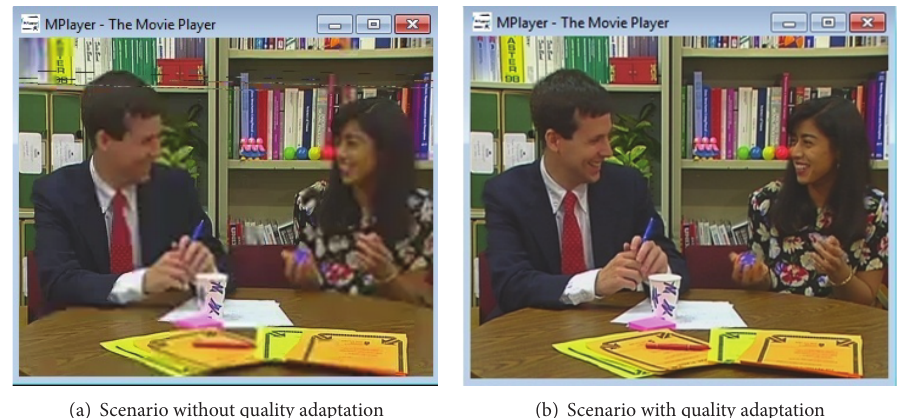
Figure 5: Subjective quality in the scenario without quality adaptation and with quality adaptation by LLI.